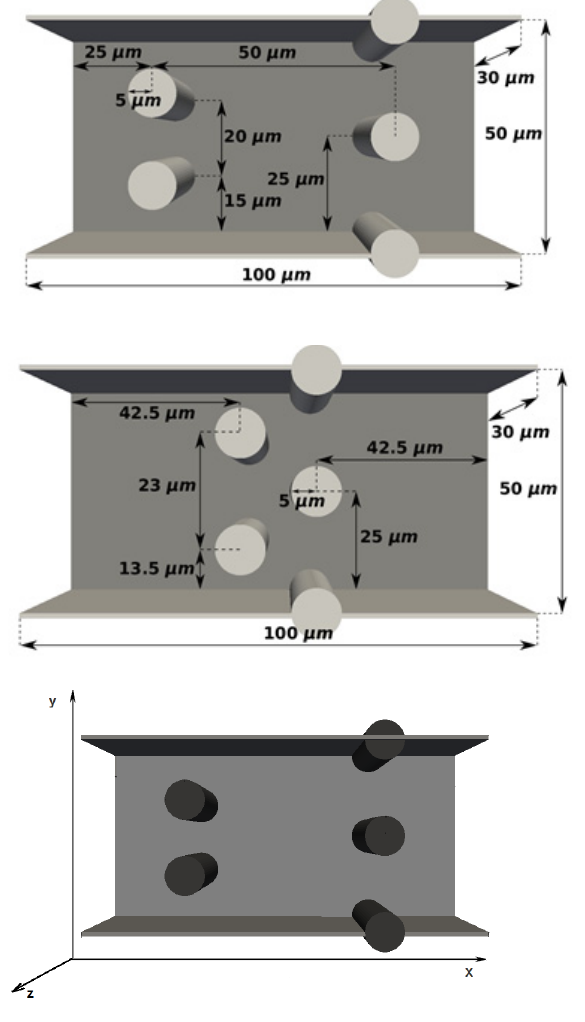
Fig. 1. Topology and proportions for channel A, channel C and orientation of coordinate axis